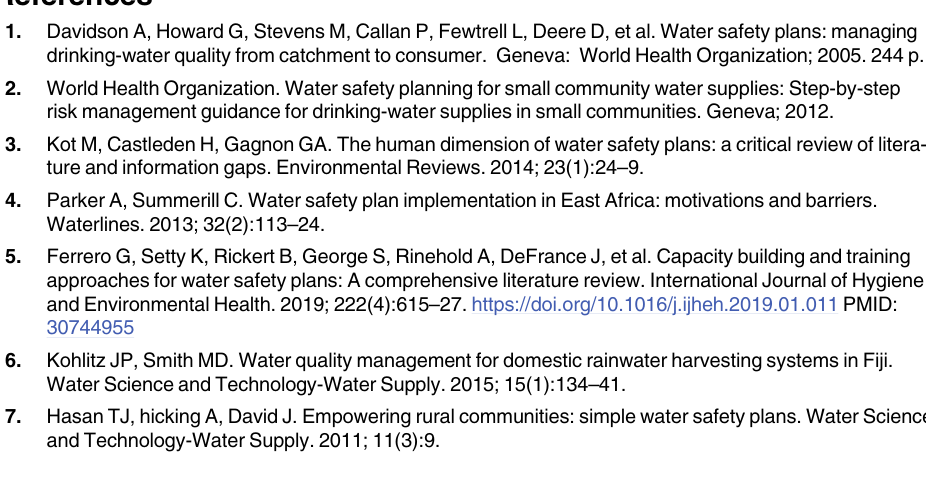
S2 Protocol. Participatory mapping topic